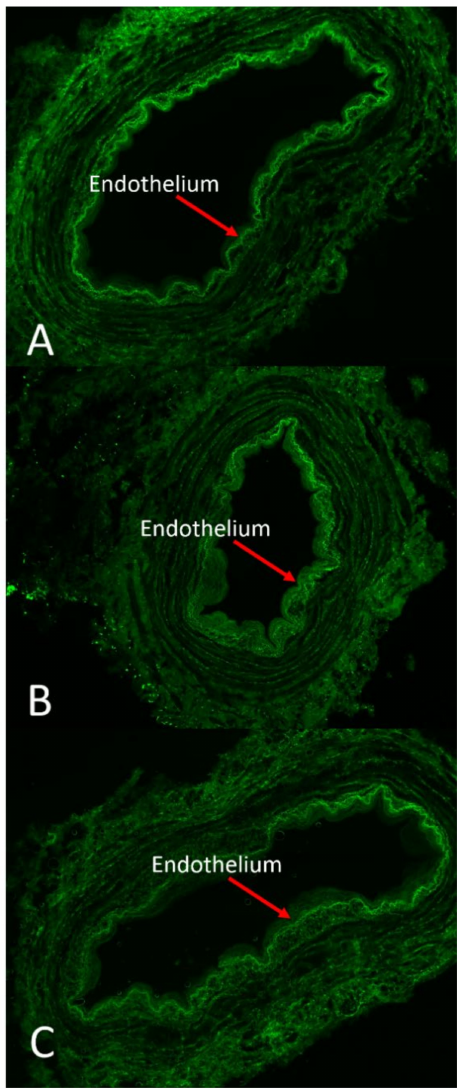
Figure 3. Changes in endothelial viability of vein segments stored in different preservation solutions. Vein segments were stored in DuraGraft ( A ), autologous heparinized blood (AHB) ( B ) and physiolog- ical salt solution (PSS) ( C ) for 2 h after vein harvesting. The high green fluorescence indicates cell apoptosis. Extensive endothelial cell death was observed in vessels preserved in PSS. Cell viability was moderately preserved in AHB. Endothelial cells remained viable in vessels preserved in Dura- Graft solution throughout the 2 h of storage. The test used measured the fragmented DNA of the apoptotic cells by catalytically incorporating fluorescein-12-dUTP(a) at the 3 (cid:48) -OH DNA ends. For these reason the test did not discern between living and dead cells. Magnification